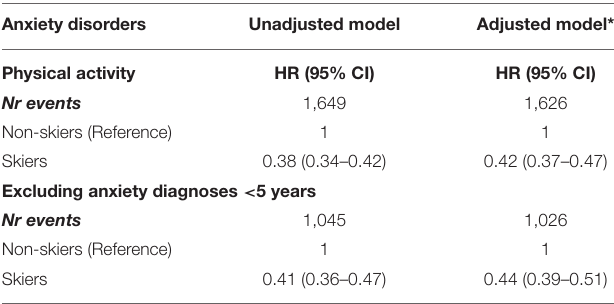
TABLE 2 | Association between physical activity and incident anxiety disorders, based on participation in a long-distance ski race (skiers) compared to non-skiers. Anxiety disorders